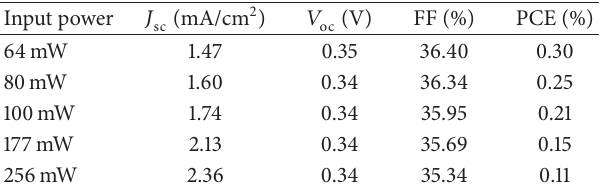
Table 3: OPVs parameters of Cells B prepared by GLAD under different illumination